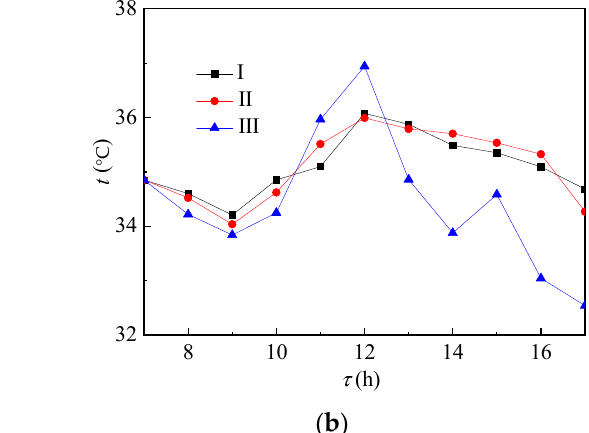
( c ) Figure 9. The change of ( a ) VFA, ( b ) pH, and ( c ) gas production of the reactants over time. 4. Conclusions Direct-absorption heating alone can save the corresponding electric energy and en- sure the normal fermentation process of the biogas slurry in the reactor, but temperature fluctuation remains a significant problem. In order to improve the stability of the fer- mentation process, it is proposed to optimize the design of this kind of reactor by adding paraffin phase change material. Filling the interlayer of the direct-absorption reactor with paraffin phase change material can effectively improve its thermal insulation and thermal storage performance,